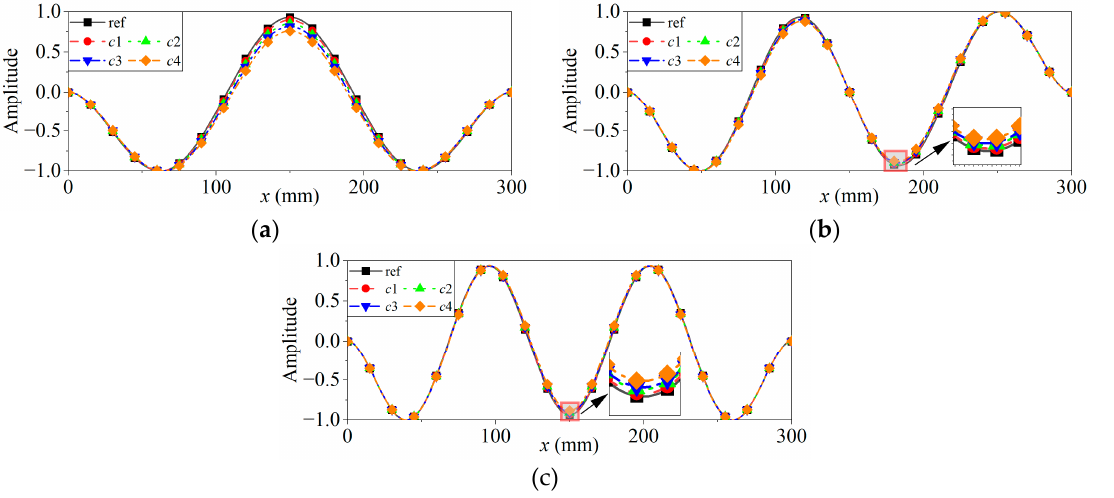
Figure 12. The mode shapes under di ff erent combined loads: ( a ) the 3rd mode shape; ( b ) the 4th mode shape; ( c ) the 5th mode shape. mode shape; ( c ) the 5th mode shape.